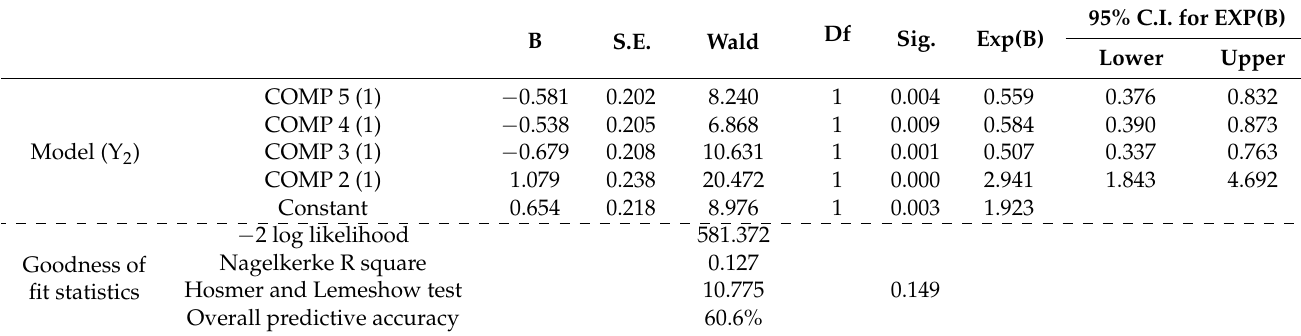
Table 9. Multivariate regression results between burglary and explanatory variables.